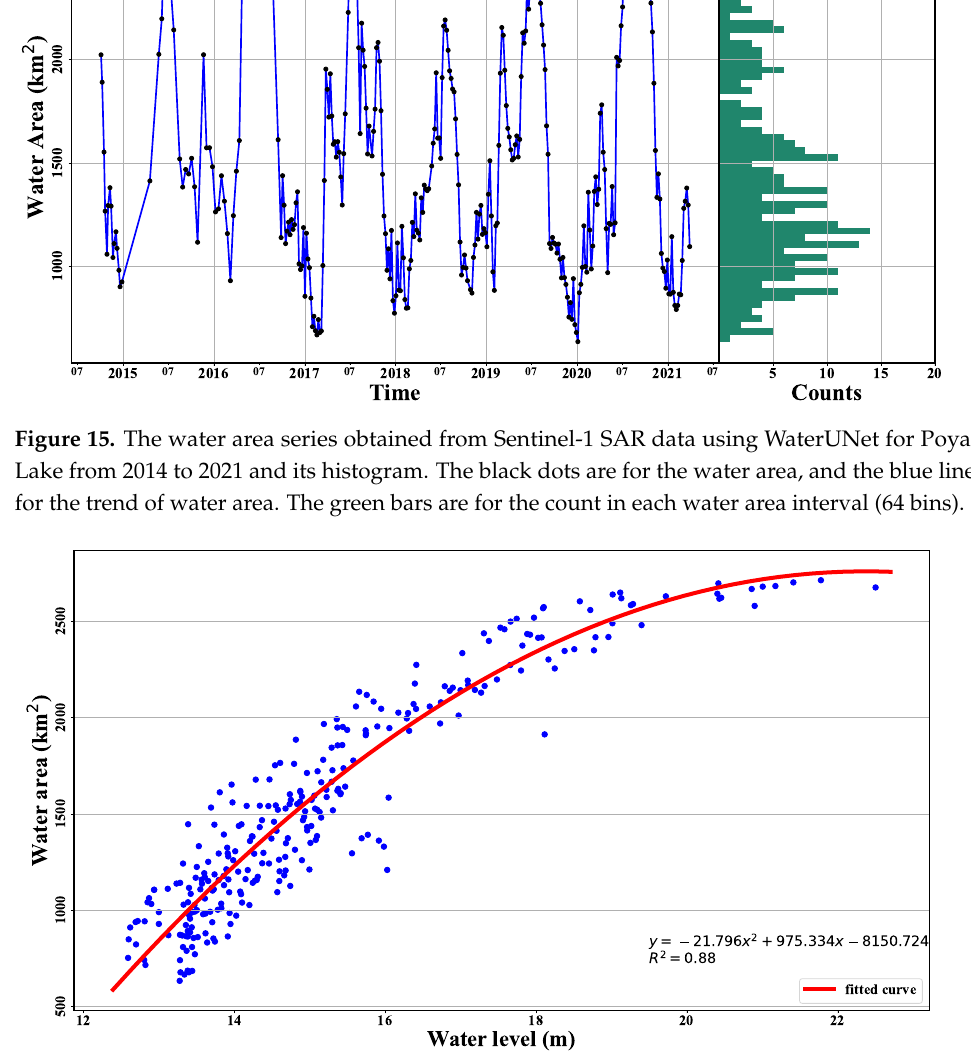
Figure 16. The relationship between the water level and water area for Poyang Lake. The red line is for the fitted curve, with “ y ” for the water area and “ x ” for the water